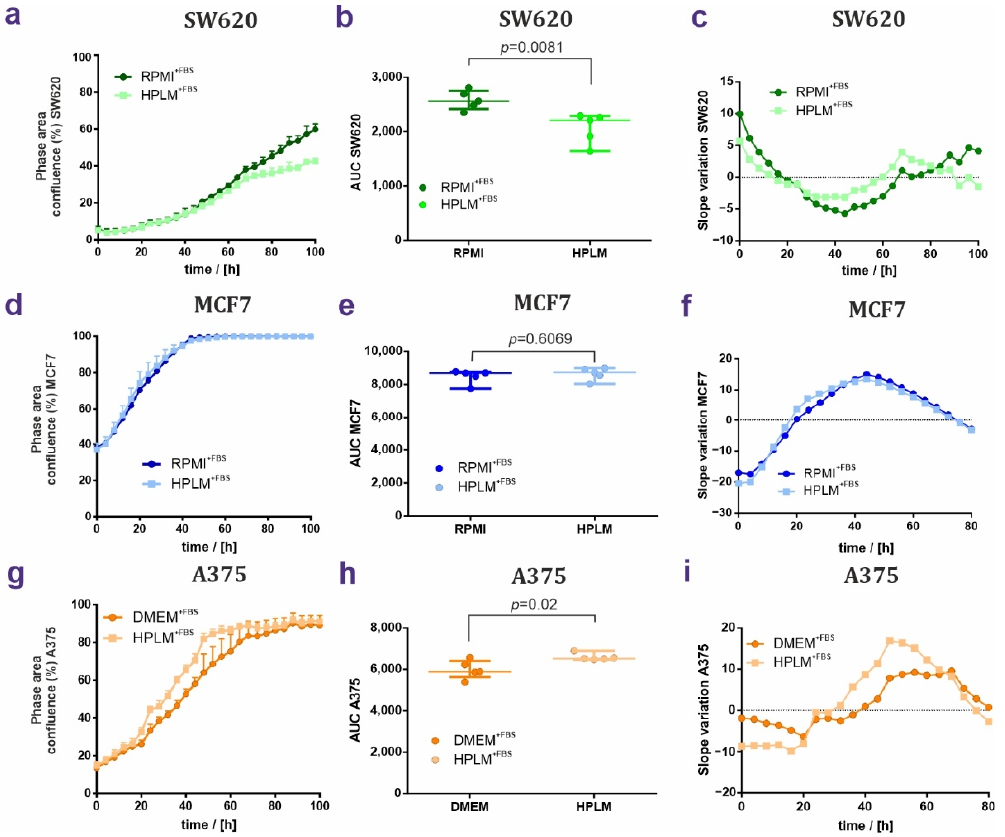
Figure 2. HPLM and RPMI/DMEM effects on cell growth of SW620, MCF7, and A375 cells. ( a – c ) Proliferation of SW620 cells grown in RPMI +FBS or HPLM +FBS . Growth curves are shown in ( a ), AUC are plotted in ( b ), and slope variations are shown in ( c ). ( d – f ) Same analyses performed for MCF7 cells grown in either RPMI or HPLM showing proliferation curves ( g ), AUC ( h ), and slope variation ( i ). ( g – i ) Proliferation of the A375 cell line grown either in DMEM +FBS or HPLM +FBS . In proliferation curves and AUC, values are represented as median ± IQR (50% range). Unpaired non-parametric t -test analysis; N = 5.